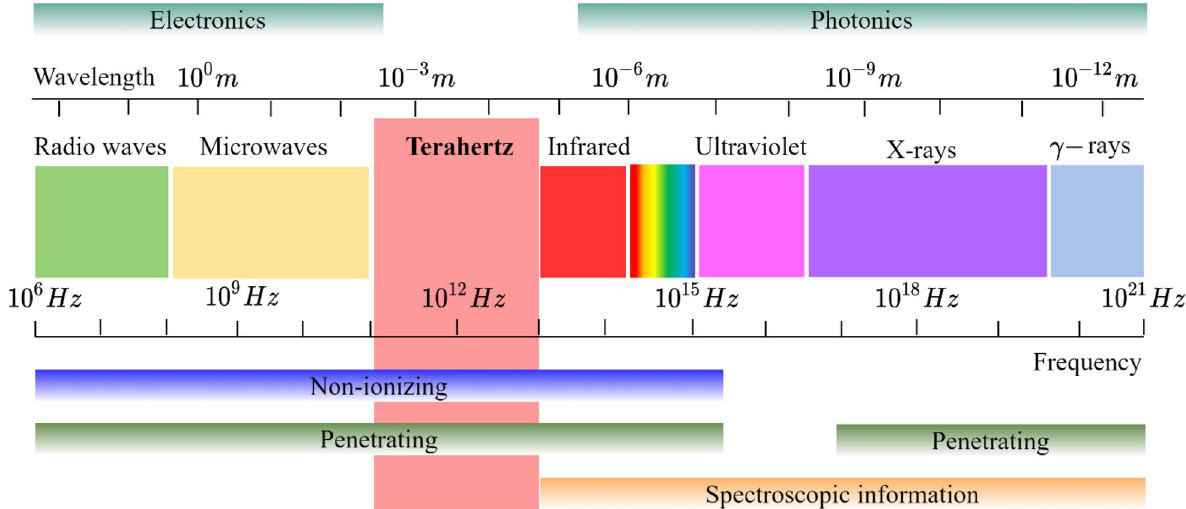
Figure 1 Illustration of the region covered by the THz band in the electromagnetic spectrum, as well as the wavelength and major characteristics of the THz